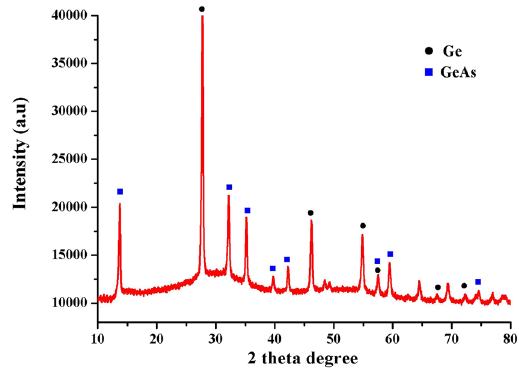
Figure 6. X-ray diffraction patterns of GeAs ultrafine